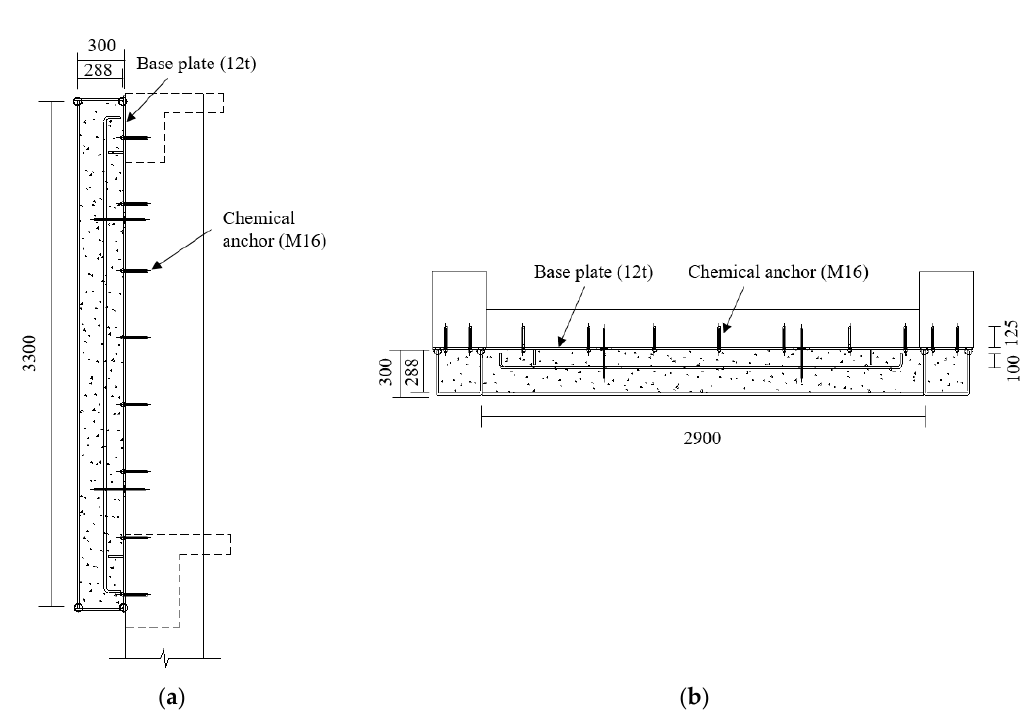
Figure 4. Details of the CFST frame in the WCFST specimens (mm): ( a ) vertical cross-section and ( b ) horizontal cross-section.